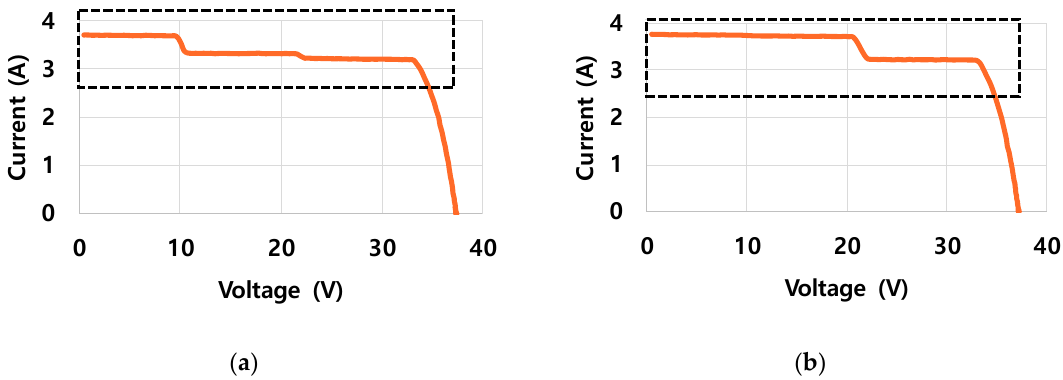
Figure 5. I–V curve for the vertically set module at a specific time: ( a ) I–V curve for east (front)-west at 14:30 p.m.; ( b ) I–V curve for west (front)-east at 12:30 p.m.